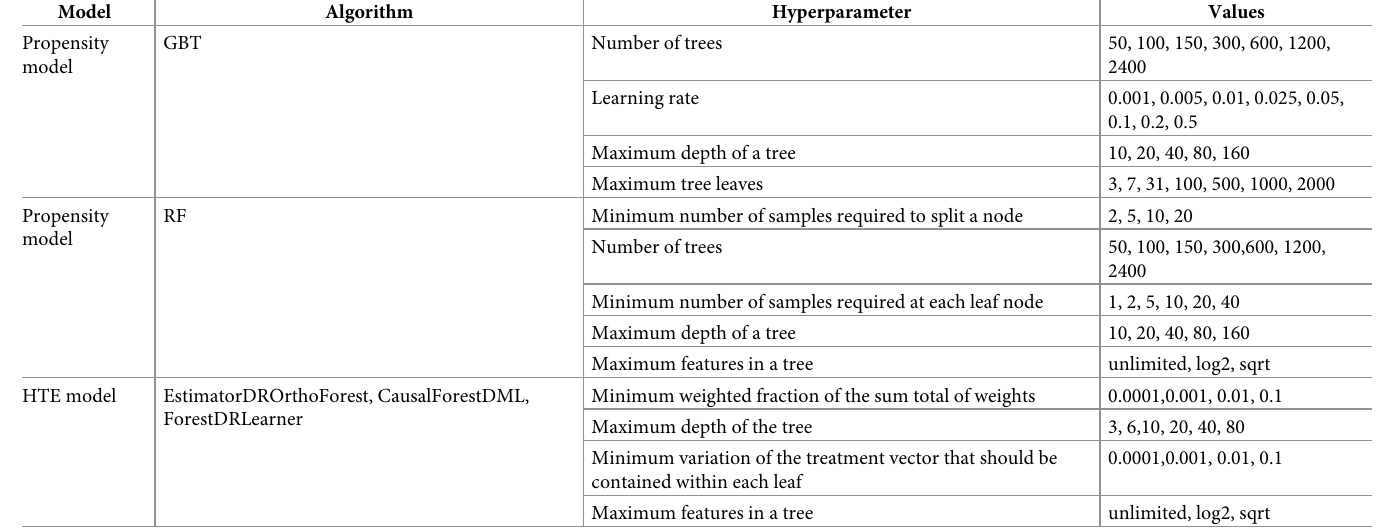
Table 3. Causal inference models’ hyperparameter values.